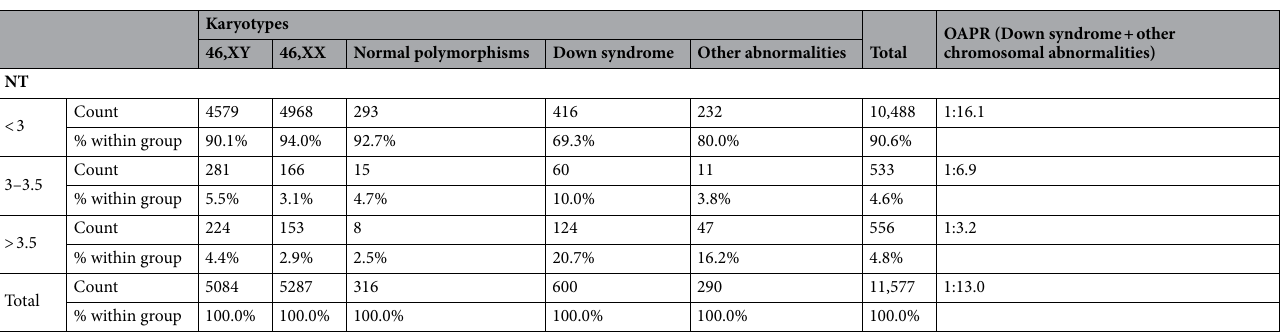
Table 8. Association between NT value and frequency of chromosomal